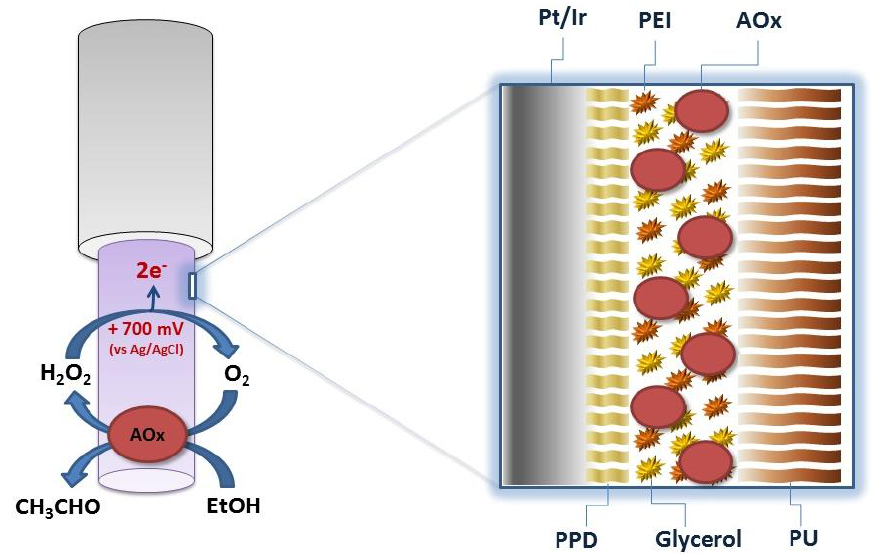
Figure 1. Schematic representation of the main design of implantable alcohol biosensors developed and characterized in this study. Pt /PPD/[{PEI(1%)+Glyc(1%)}/AOx]10/PU(1%). c Pt/Ir: 1 mm long, 125 μm diameter Pt/Ir cylinder; AOx: alcohol oxidase; PPD: poly- ortho -phenylenediamine; PU: polyurethane; PEI: polyethyleneimine. Different enzyme stock solutions were used, the concentration of which ranged from 100 to 800 U·mL −1